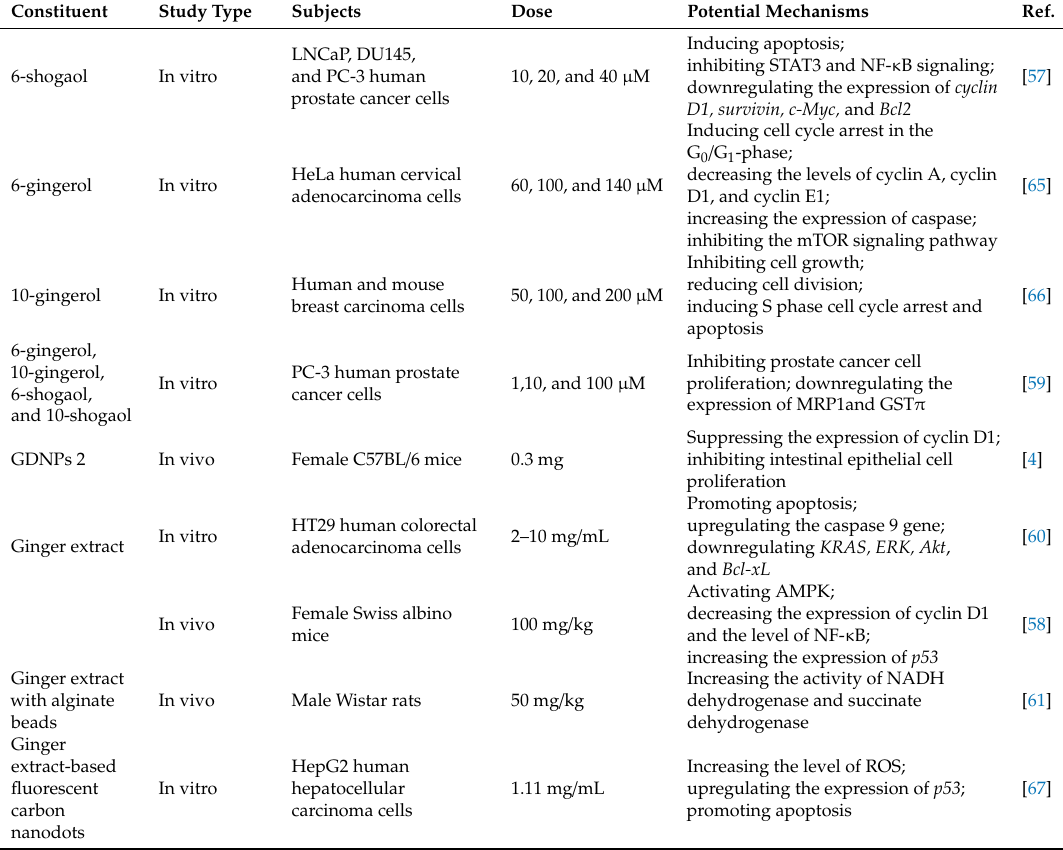
Table 4. Cytotoxic activity and potential mechanisms of